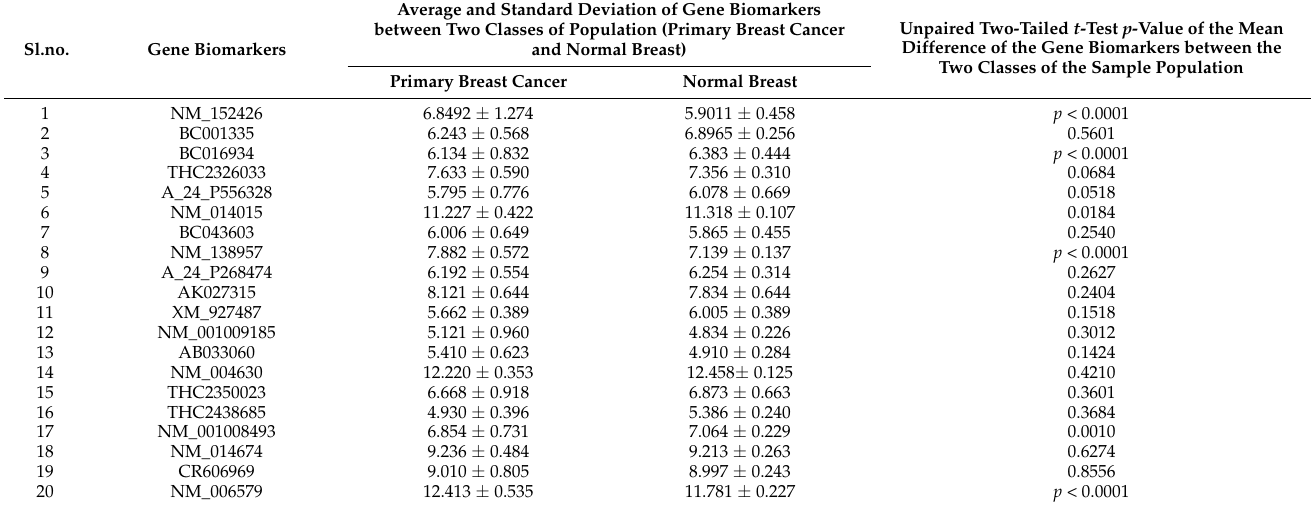
Table 6. A listing of the twenty features (Gene biomarkers) attained using mRMR and the resultant mean difference of each twenty features between two classes of the sample population (primary breast cancer and normal breast) at a significance level of